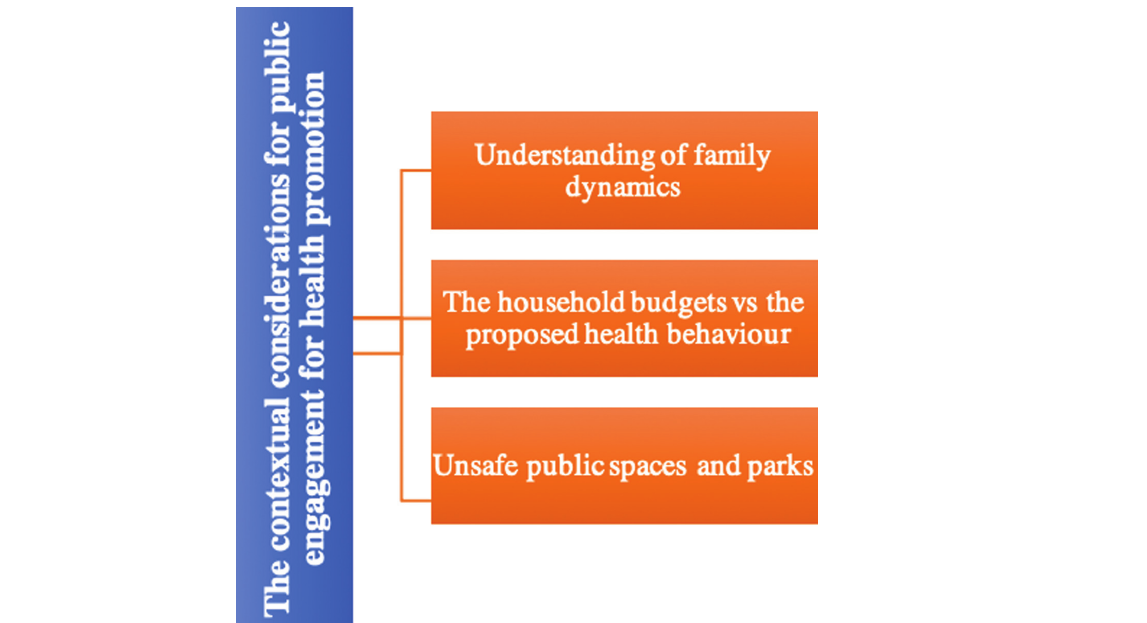
Figure 3. Contextual considerations of Eat Smart to Play Hard (Source: Authors,